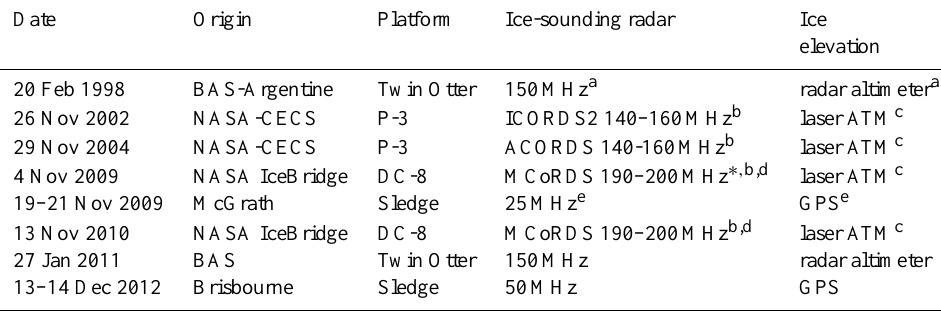
Table 1. Details of the radio-echo sounding and altimeter surveys used in this analysis. Date Origin